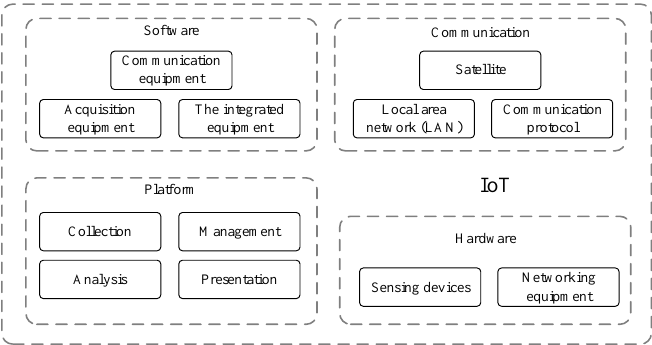
Figure 1. The composition of the Internet of Things Data security is a critical issue when improving the performance of healthcare devices or applications that support the Internet of Things. Future